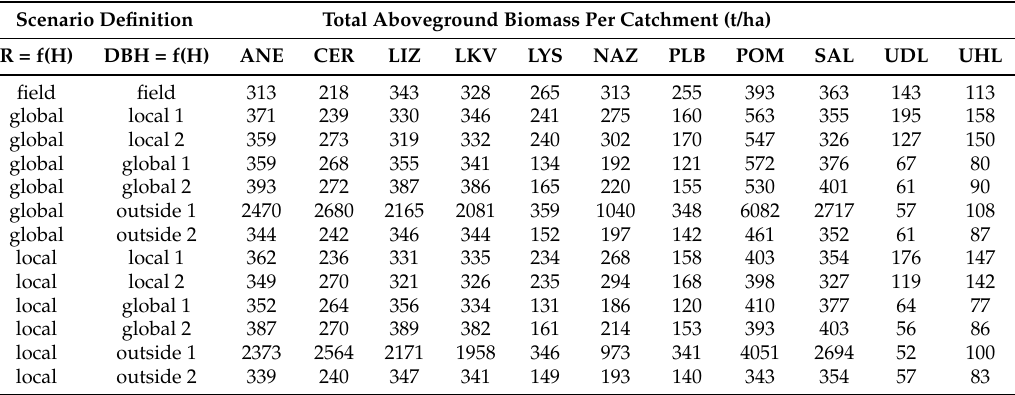
Table 6. Total aboveground biomass estimates per catchment (t/ha) obtained directly from the field data (in the first row) and from airborne laser scanning data for 12 scenarios, differing in their combinations of local or global allometric equations for (i) estimation of tree crown radius R in tree detection and (ii) stem diameter estimation in biomass